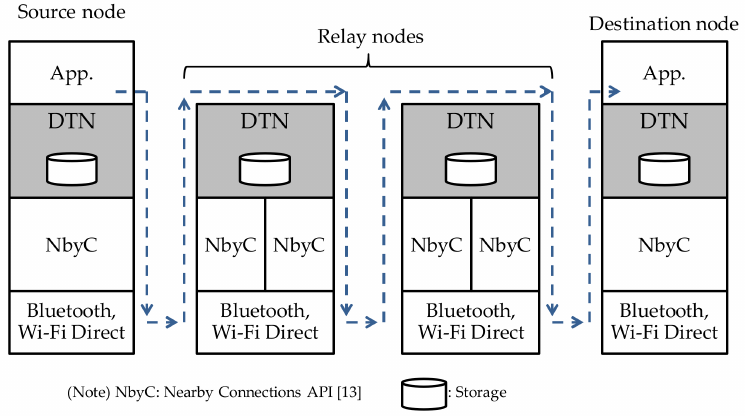
Figure 2. Proposed DTN architecture.